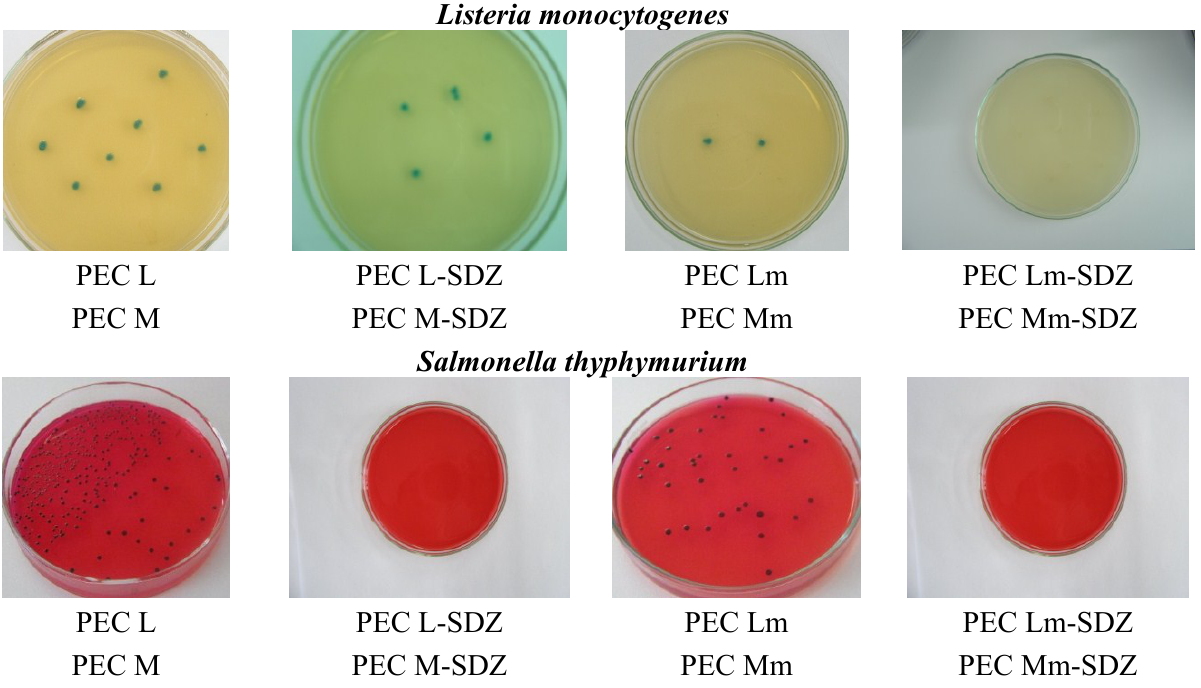
Figure 9. Representative microscopical aspects of the colonies of Escherichia coli , Listeria monocytogenes and Salmonella thyphymurium grown over polyelectrolyte complexes based chitosan/sodium hyaluronate (CS/HA PECs) without and with sulfadiazine (SDZ)